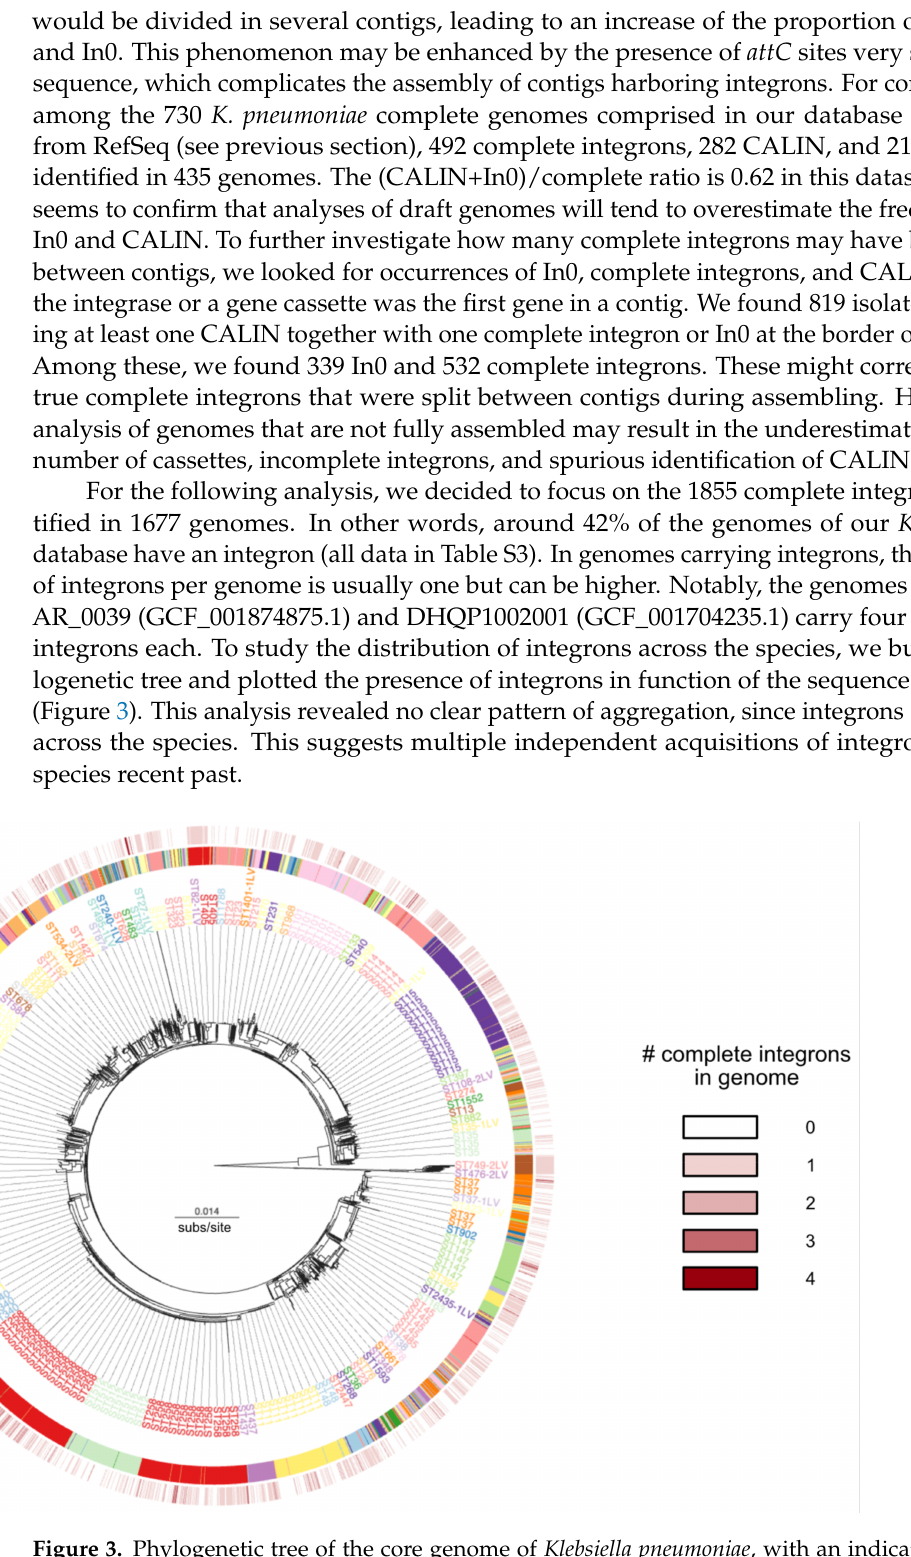
Figure 3. Phylogenetic tree of the core genome of Klebsiella pneumoniae , with an indication of the sequence type (ST) in the ribbon (and mention to the most frequent in the intermediate circle). The outer circle indicates the number of complete integrons in each genome. Tree was built as indicated in Methods and drawn using Microreact